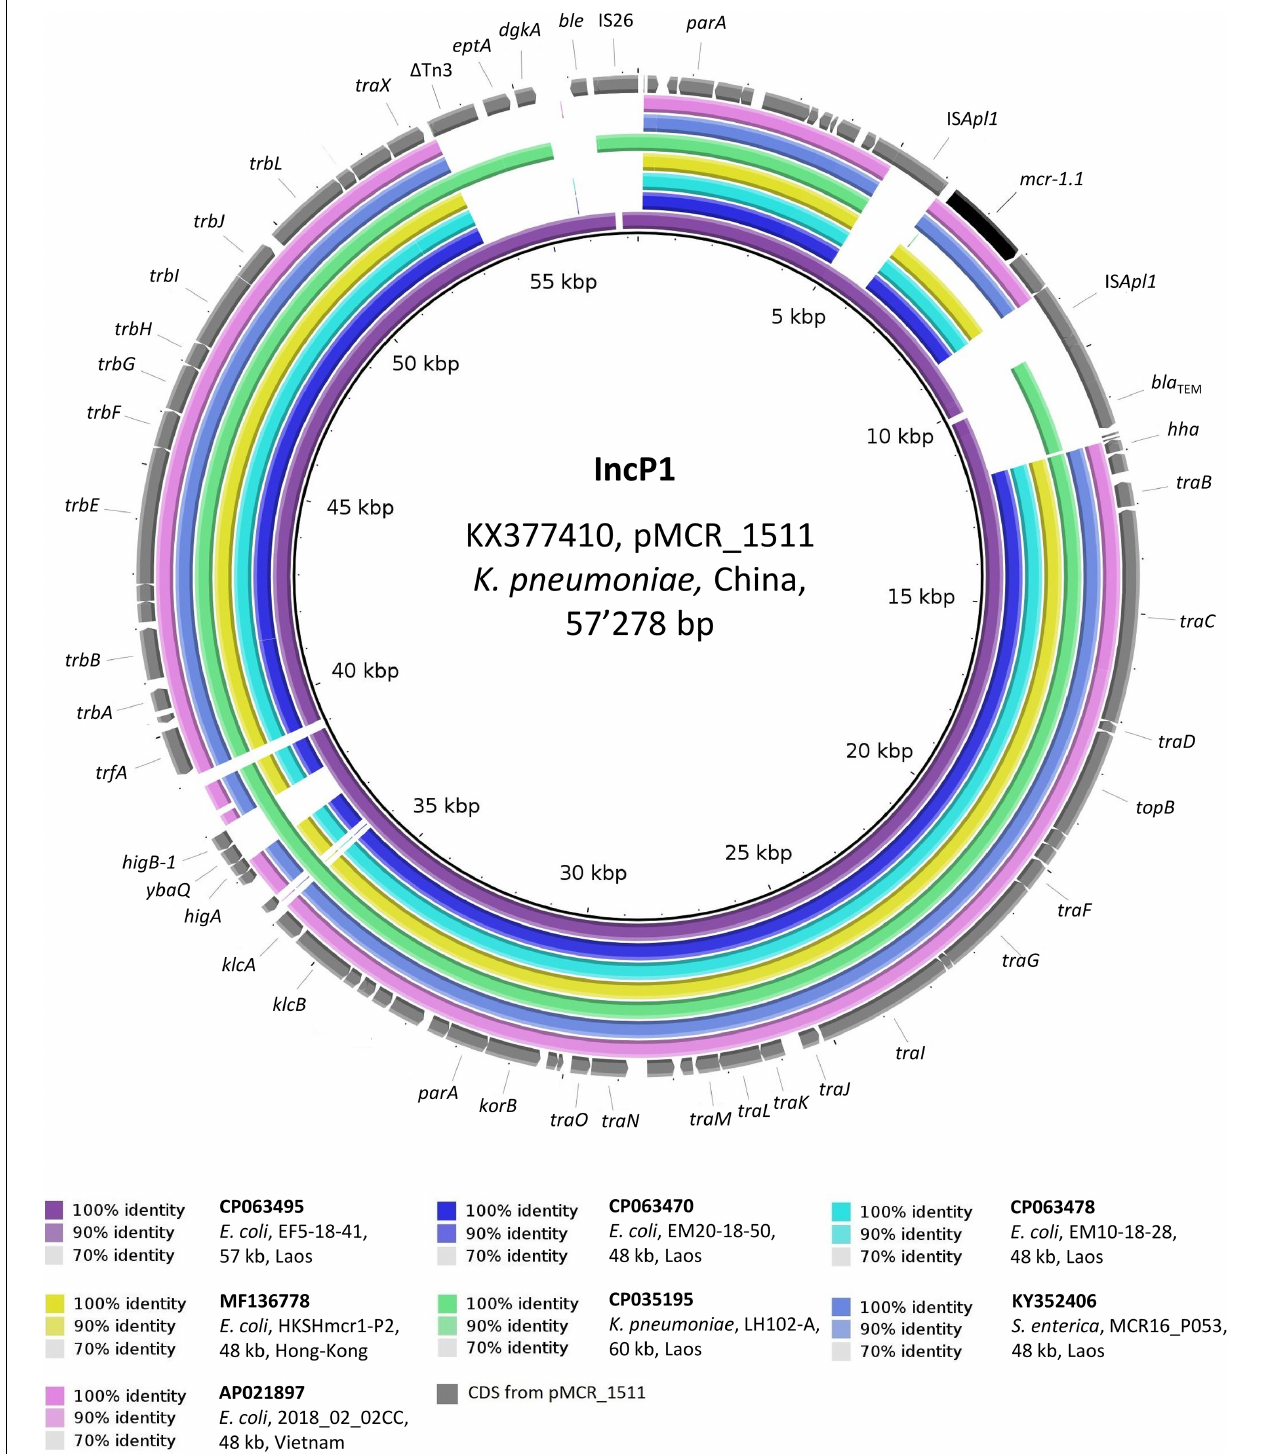
FIGURE 4 | BLASTn comparison of IncP1-type plasmid sequences. The IncP1-type plasmid sequences from the present study were compared to other sequences that were selected based on high homology in a BLASTn search against the NCBI non-redundant nucleotide collection (on 10.11.2020). pMCR_1511 (GenBank accession: KX377410) was used as reference sequence. Rings were constructed using BRIG (BLAST Ring Image Generator) v.0.95. The colored rings represent similarities to the reference sequence. We report GenBank accession, species of isolation, strain name, sequence size and country of origin. CDS are represented as arrows in gray. The mcr-1.1 gene is shown in black. (cid:49) refers to truncated CDS.